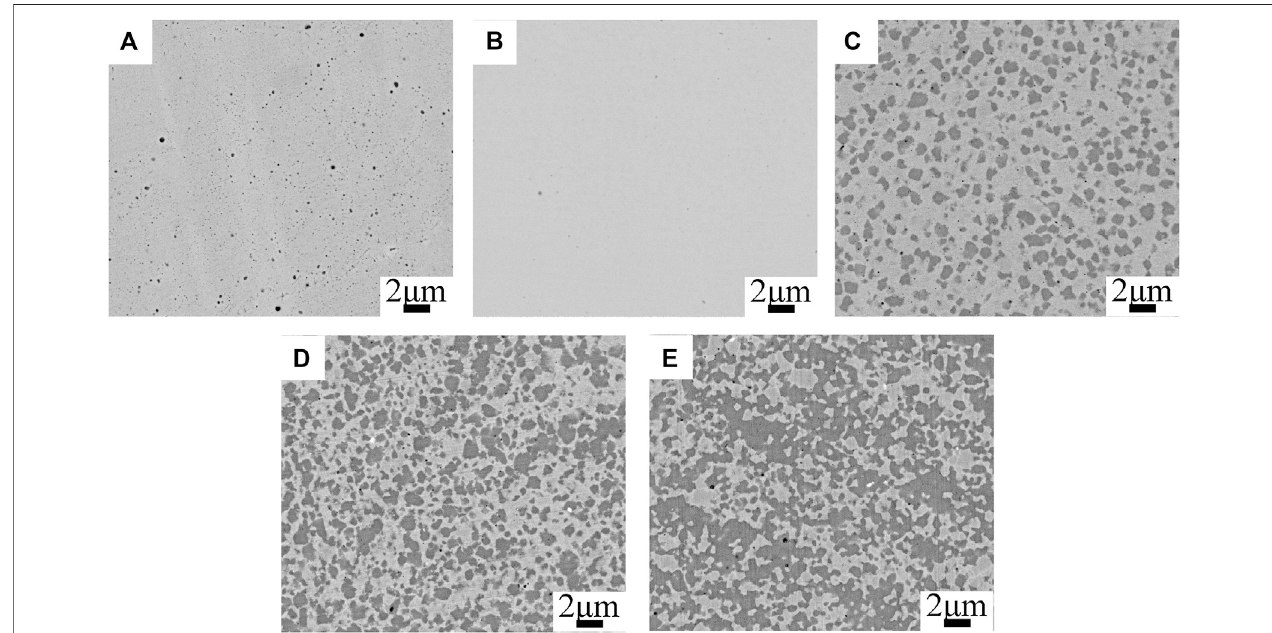
FIGURE 4 | SEM back scatter electron images of the bulk FeCoNi(CuAl) x MEA and HEAs: (A) x (cid:1) 0; (B) x (cid:1) 0.4; (C) x (cid:1) 0.6; (D) x (cid:1) 0.8; (E) x (cid:1) 1.0.